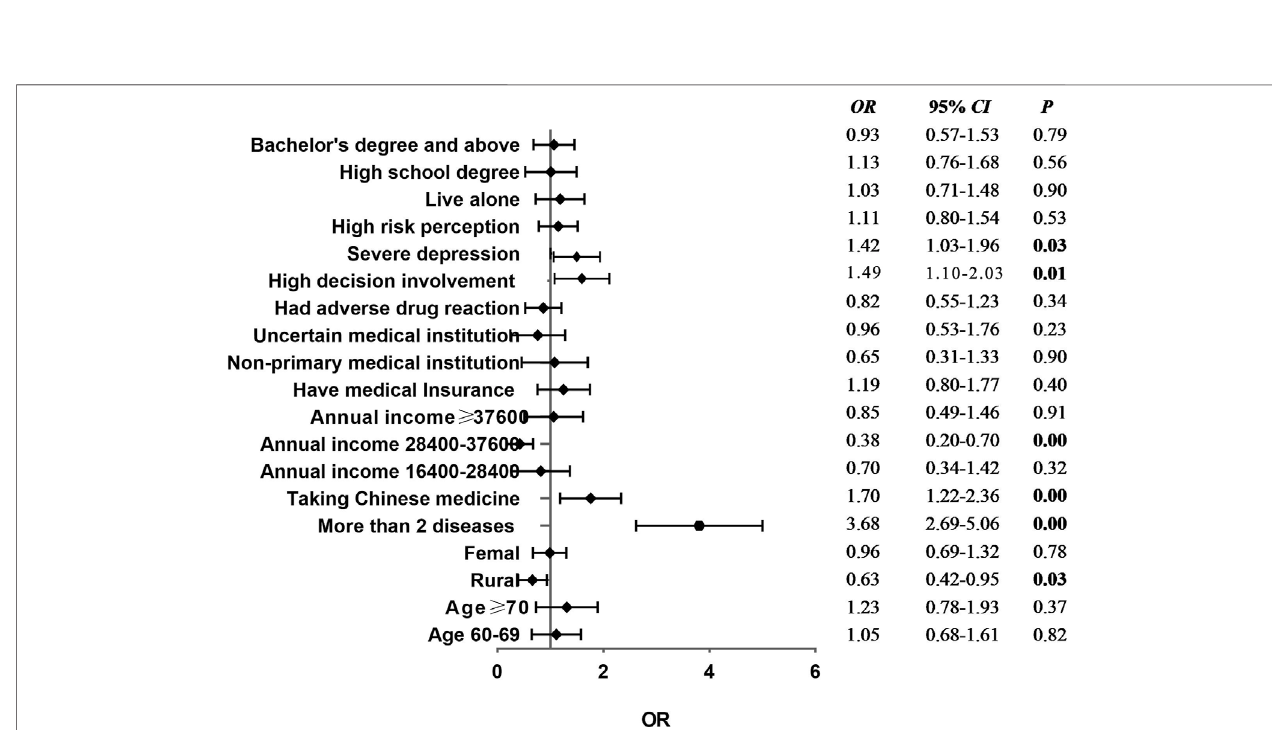
Frontiers in Pharmacology |